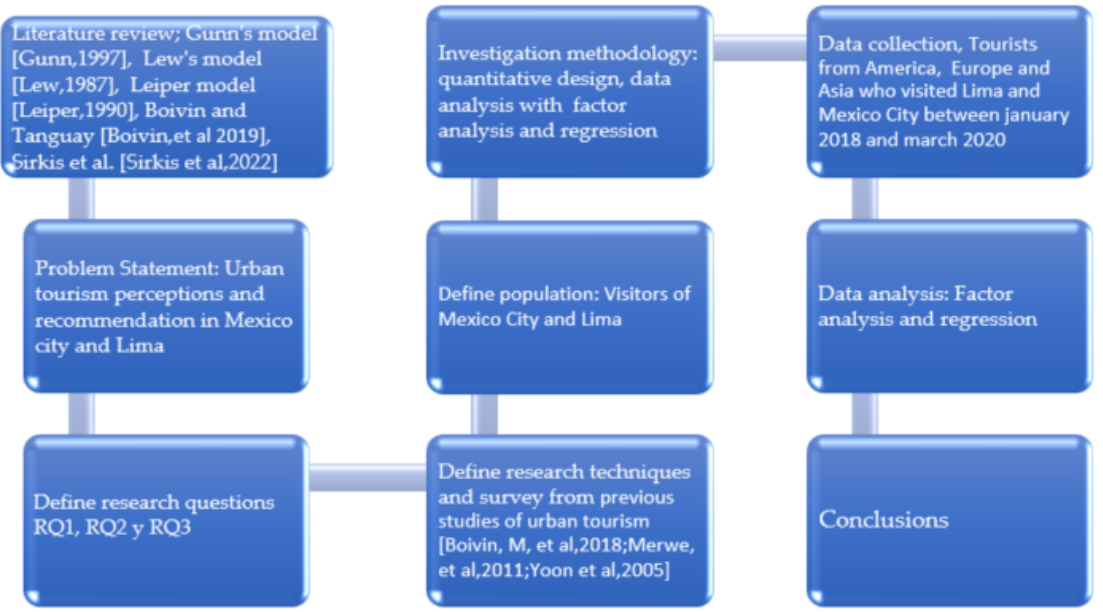
3 AEs for pediatric patients receiving antiangiogenic drugs Figure 1. Proportion of serious/Grade Figure 7. Diagram research process ≥ as monotherapies (drugs assessed in less than 20 patients or not reporting both serious/Grade AEs).